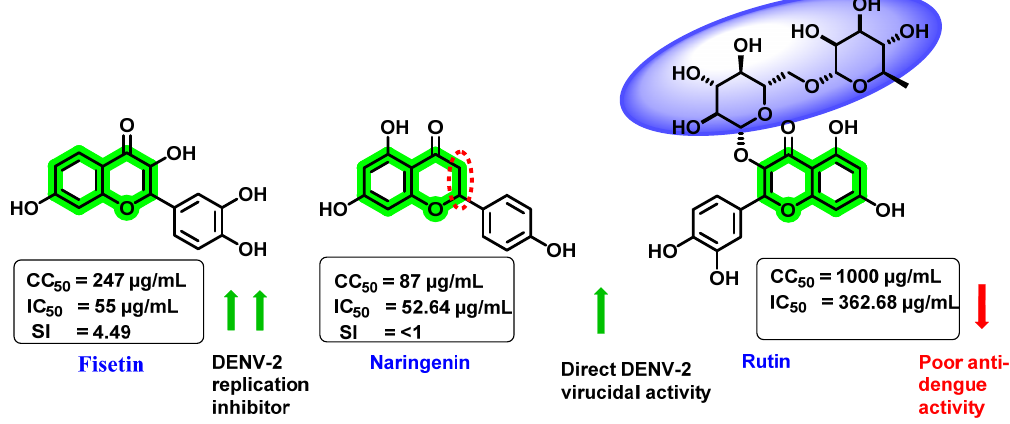
Figure 10. Structure , CC 50, and IC 50 of fisetin, naringenin, and rutin.